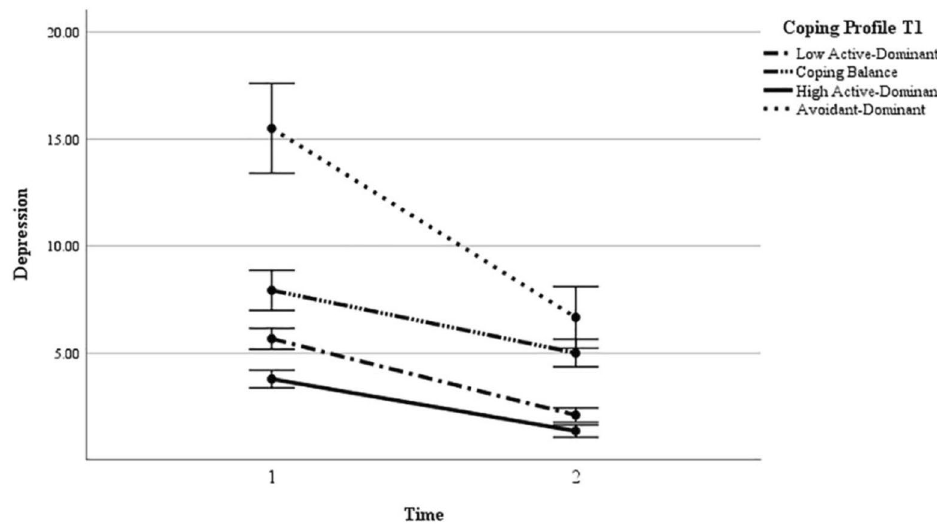
Figure 3. Depression across the two times and as a function of coping